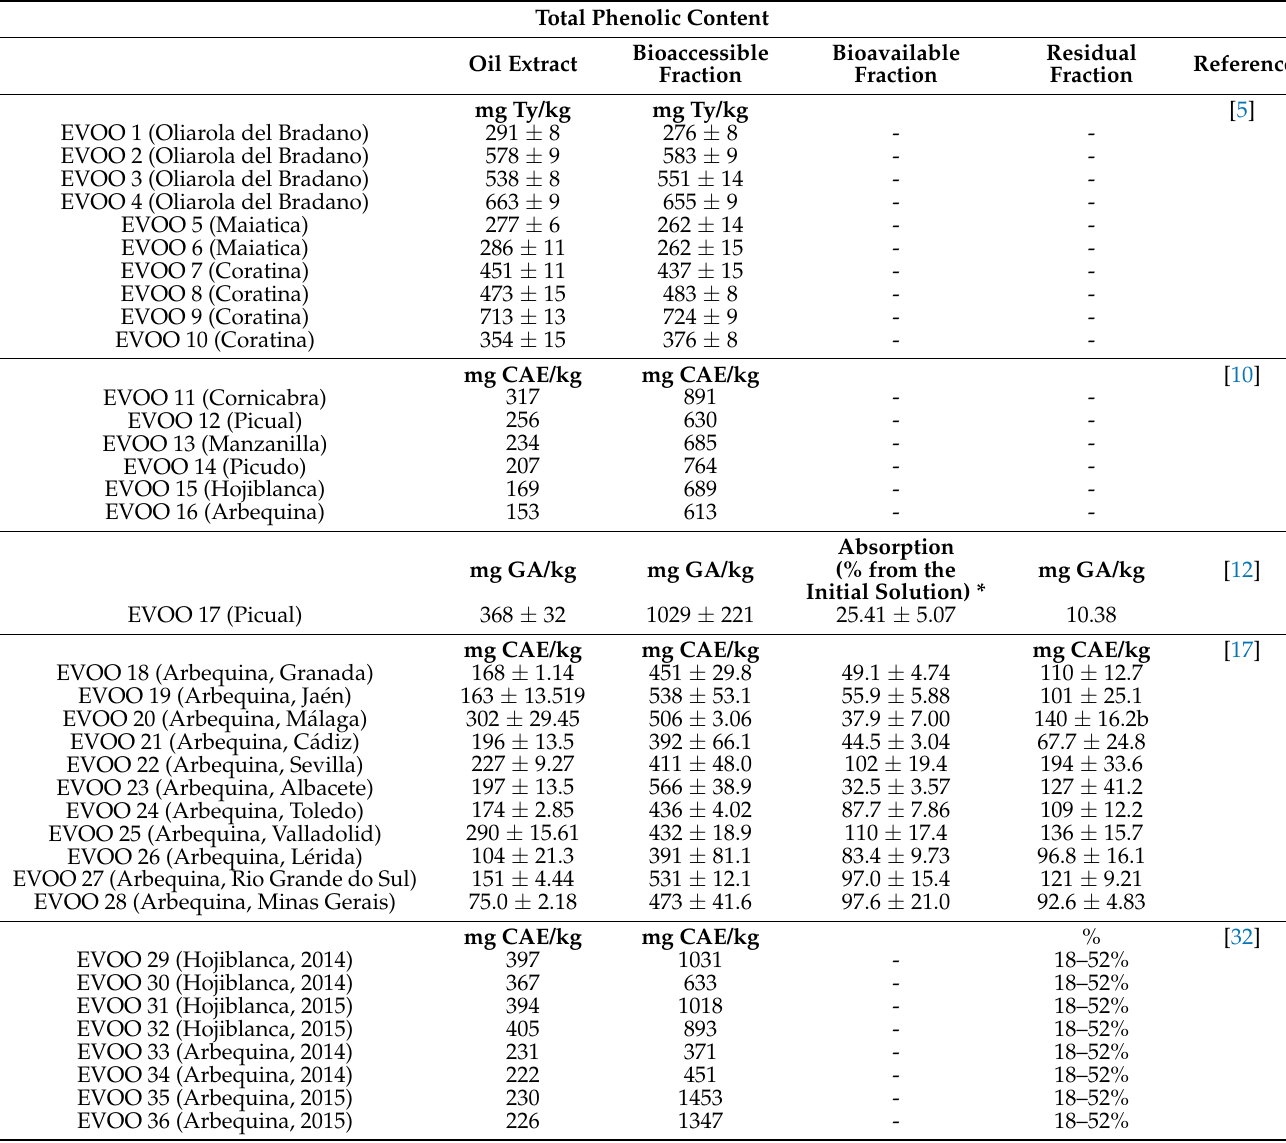
Table 2. Total phenolic content determined by the Folin–Ciocalteu method in the oil extracts and in the bioaccessible and bioavailable fractions after in-vitro digestion of the oil